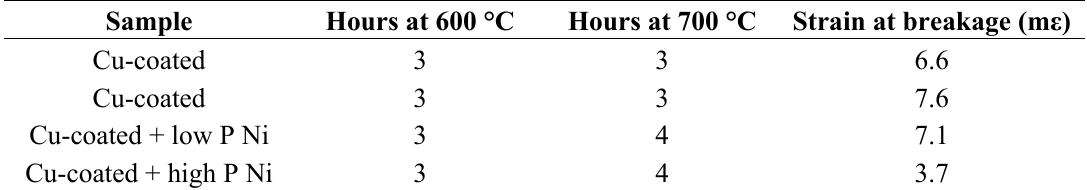
Table 2. Tensile strength of metal-coated fibers after two-step annealing, firstly at 600 °C and then after increasing the temperature to 700 °C.